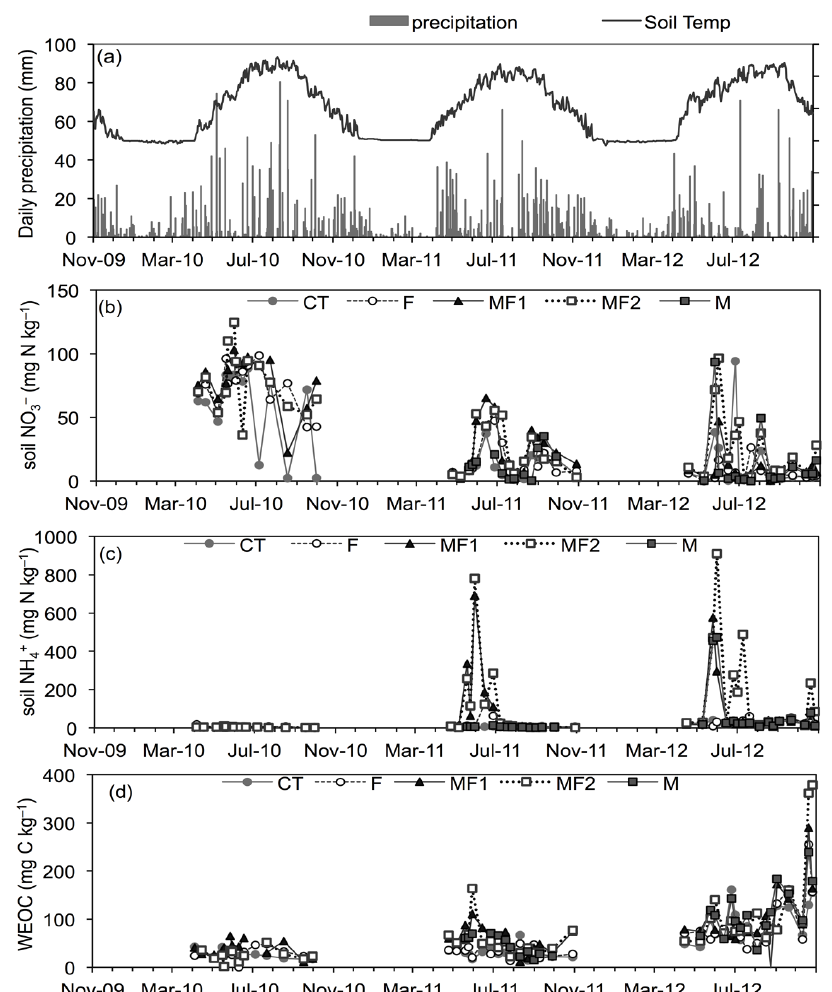
Figure 1. Daily average soil temperature and precipitation ( a ), soil NO 3 − concentration ( b ), soil NH 4+ concentration ( c ) and water extractable soil organic carbon (WEOC) ( d ) from 2010 to 2012 in experiment 1. CT is unfertilized control plot; F is inorganic fertilizer ‐ only plot; MF1 is inorganic fertilizer plus composted cattle manure applied since 2005 plot; MF2 is inorganic fertilizer plus composted cattle manure applied since 2010 plot; M is composted cattle manure ‐ only plot.